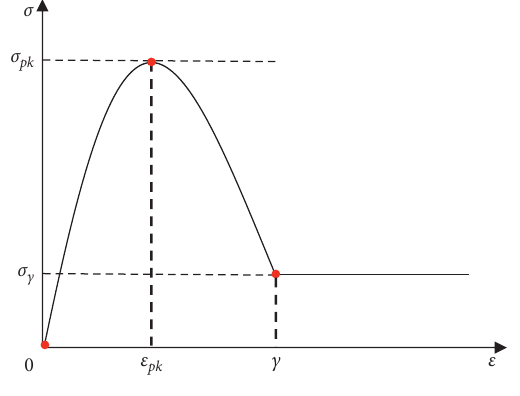
Figure 1: Stress-strain